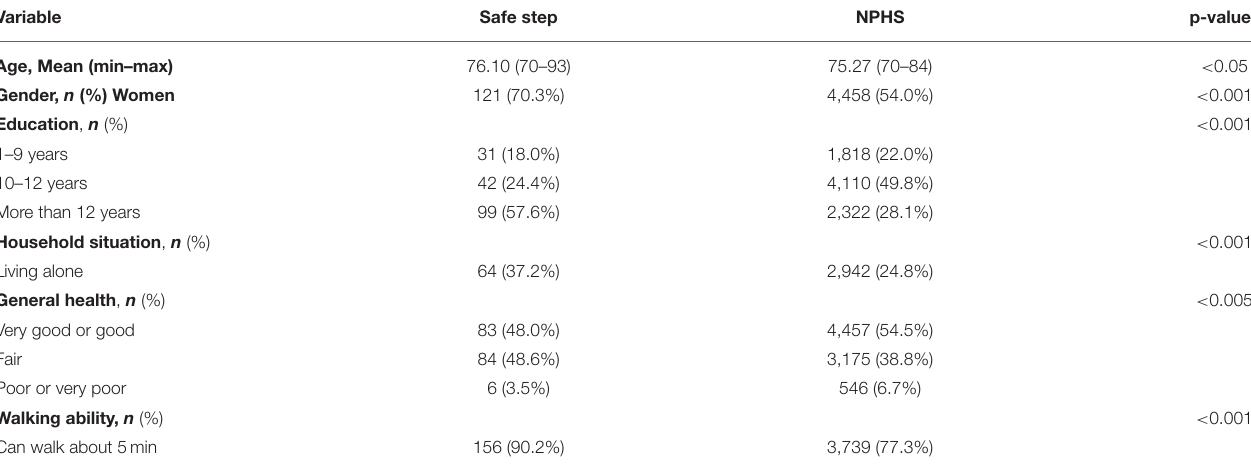
TABLE 2 | Distribution of self-reported characteristics of the Safe Step sample and National Public Health Survey (NPHS).